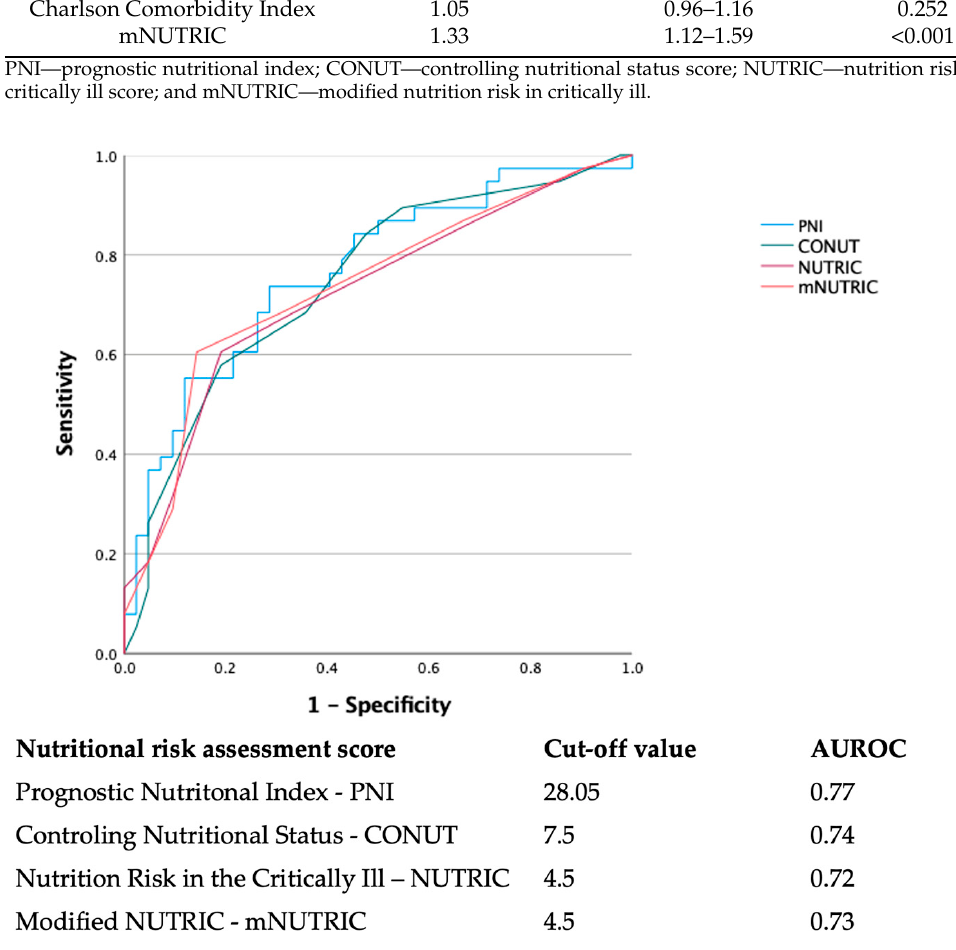
Figure 2. The AUROC curves of the nutritional risk assessment scores for predicting in-hospital